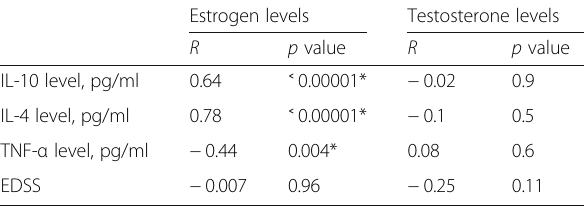
Table 2 Correlation between hormonal levels (estrogen and testosterone), cytokine levels, and EDSS in